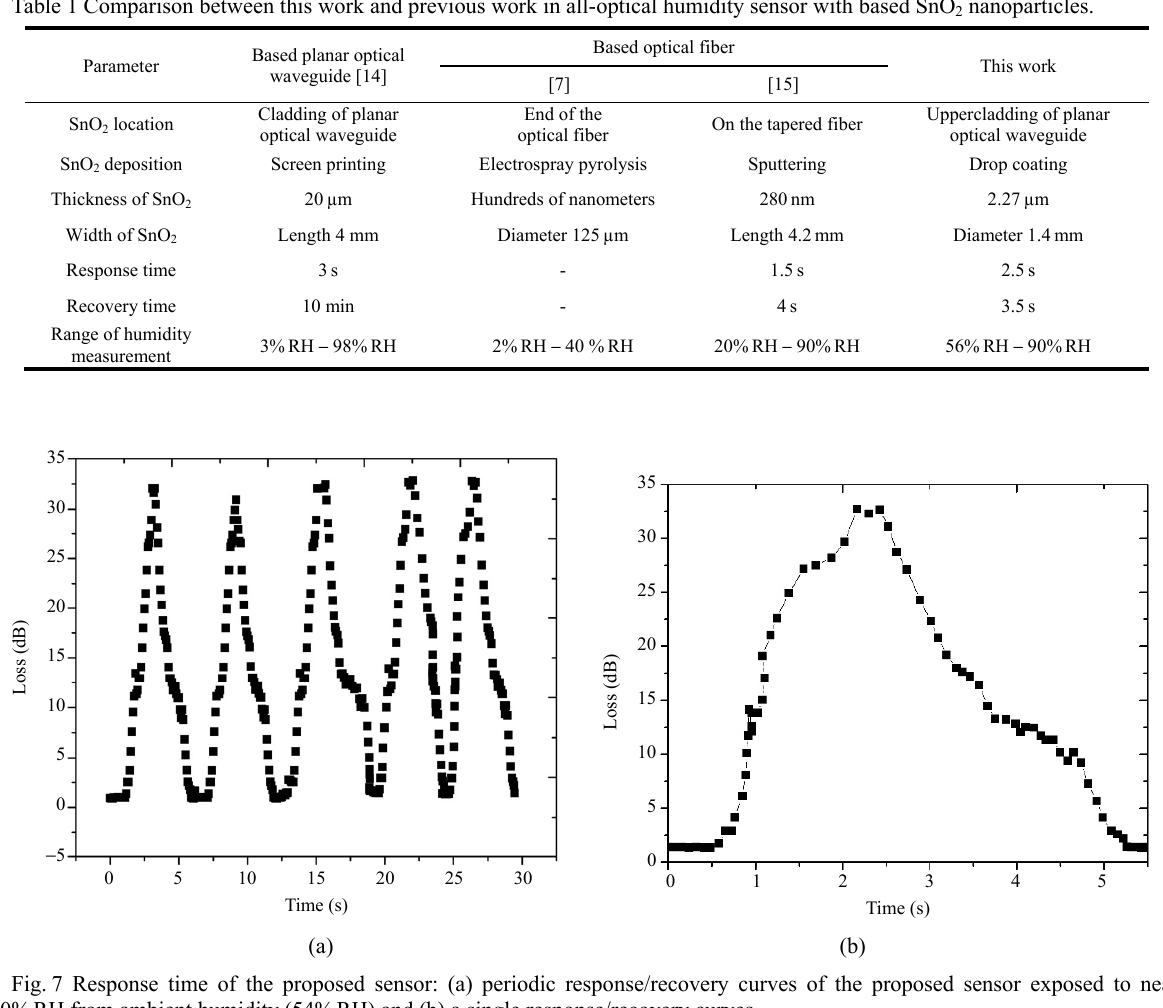
Fig. 7 Response time of the proposed sensor: (a) periodic response/recovery curves of the proposed sensor exposed to nearly 100% RH from ambient humidity (54% RH) and (b) a single response/recovery